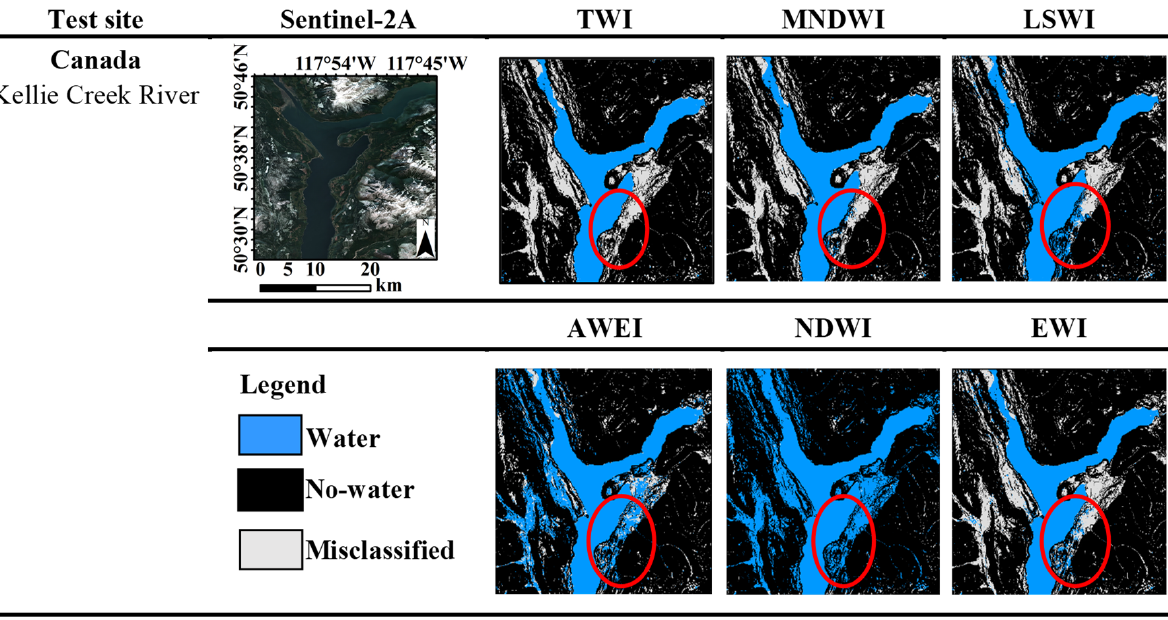
Figure 8. Comparison of water extraction results using seven different water indices at the Kellie Creek River site in Canada. Sentinel-2A color composite, bands 4, 3, 2 coded RGB. The red circles mark the areas where snow and shadows are present in the Sentinel-2 imagery.